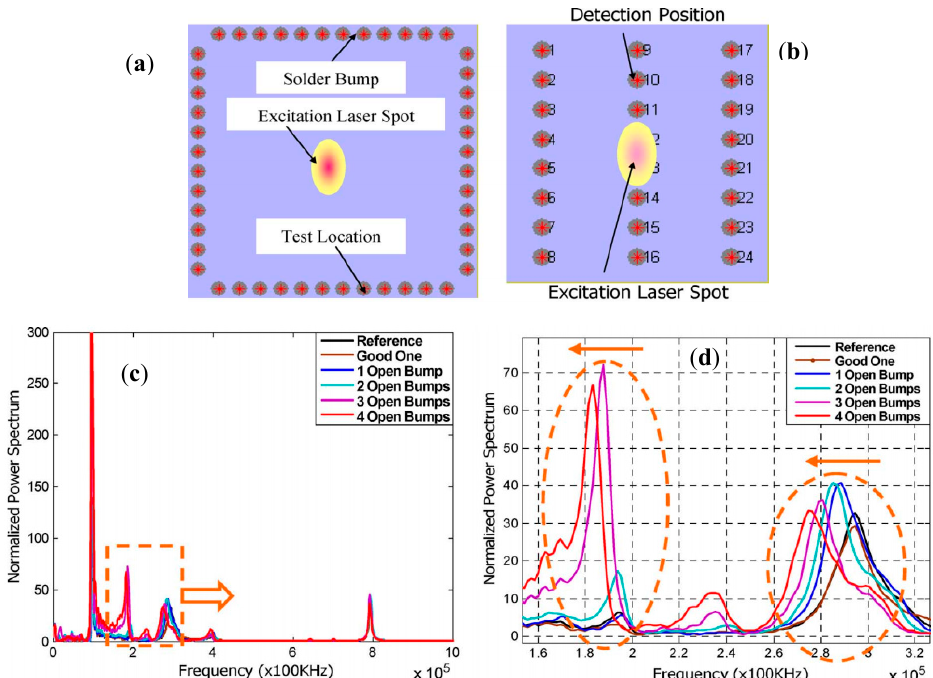
Figure 12. Flip chip solder bump inspection using SAW: locations of laser excitation and sensing for ( a ) Test specimen I and ( b ) Test specimen II (with different solder bump arrangements), ( c ) Power spectrum of SAW under pulsed laser excitation, and ( d ) Close-up of the power spectrum in range of 160–320 KHz for test specimen II [68].